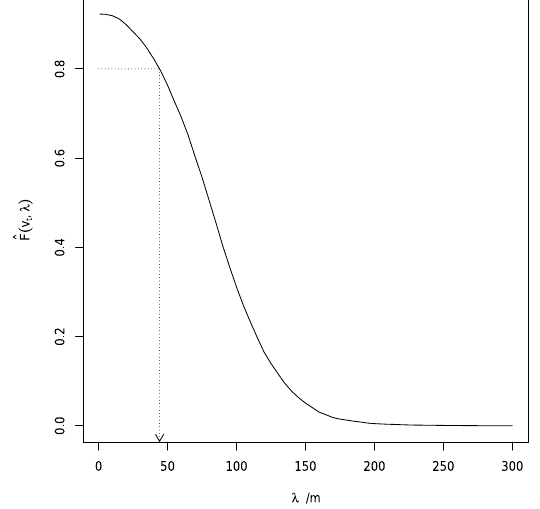
Figure 5. Value of kriging variance at the centre of a square grid cell as a function of grid spacing, λ . The solid line is the expected value of kriging variance over the distribution of parameters, and the dashed line are the values given the maximum likelihood estimates of those parameters.